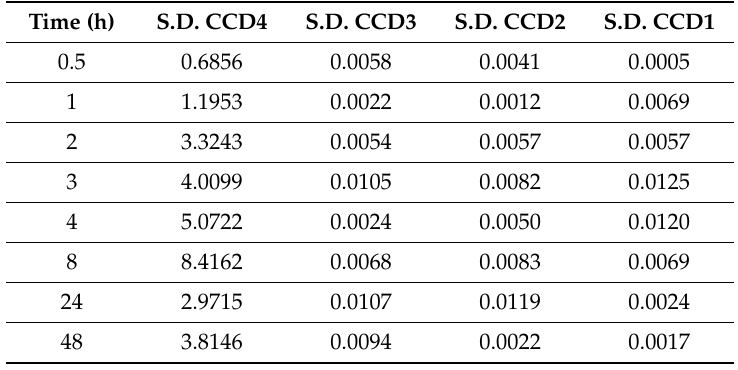
Figure 7. Drug release profiles for the CCD1-CCD4 drug delivery systems ( a ) for 7 days and ( b ) 8 h. The values are presented as the mean of three individual measurements ± S.D. Table 3. Standard deviation values for the analyzed samples obtained for DCF release kinetics.